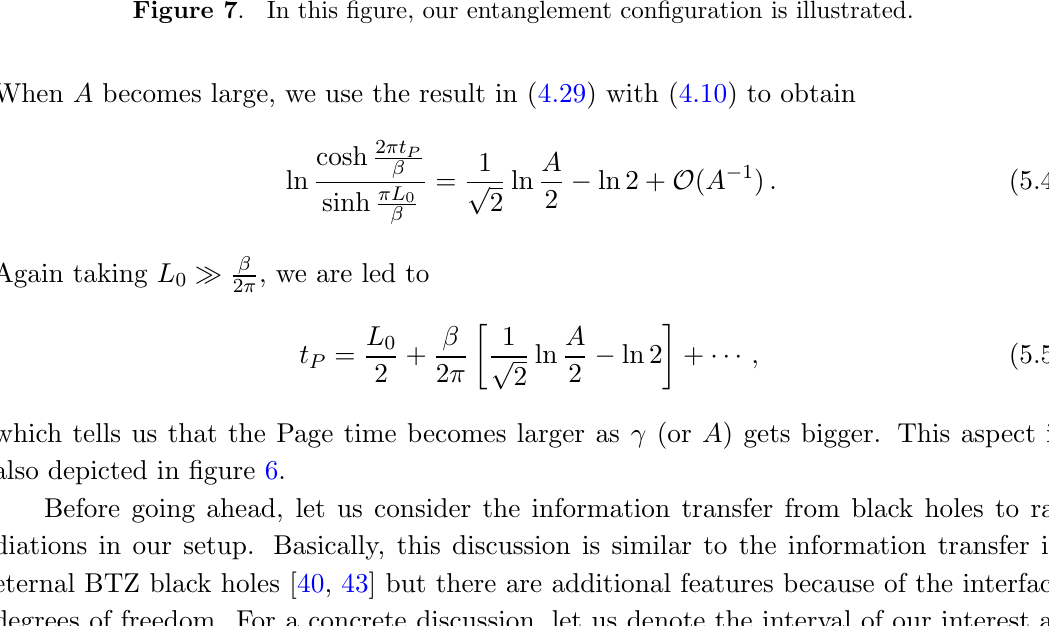
Figure 7 . In this (cid:12)gure, our entanglement con(cid:12)guration is